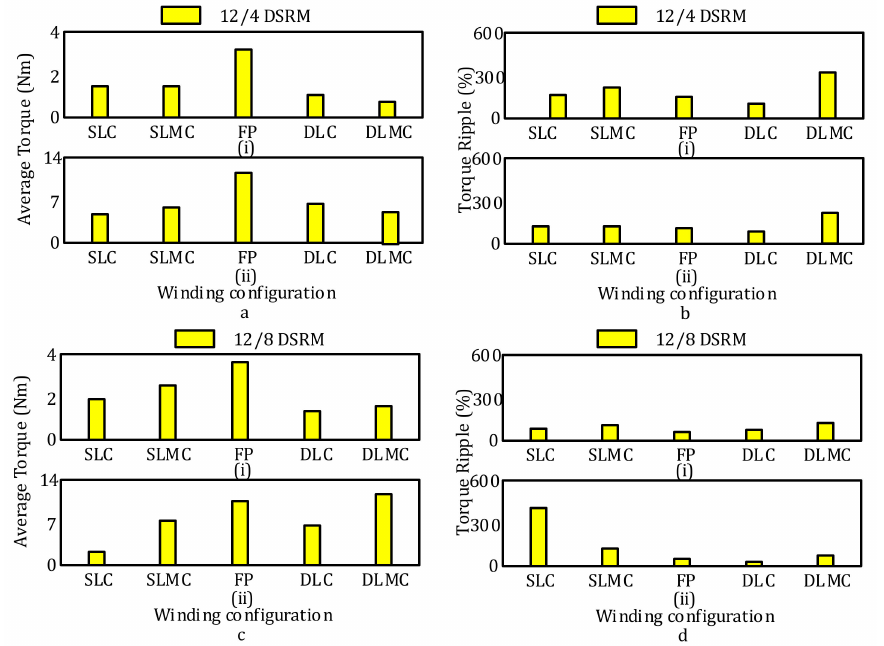
Figure 3. Comparison of torque performance with different winding configurations at (i) 10 Arms and (ii) 40 Arms ( a ) Average torque of 12/4 machines, ( b ) Torque ripple coefficient 12/4 machine, ( c ) Average torque of 12/8 machines, ( d ) Torque ripple coefficient of 12/8 machines